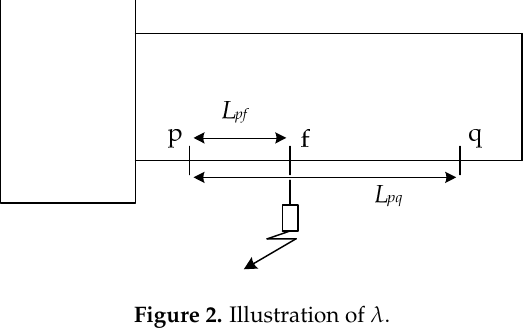
Figure 2. Illustration of λ .